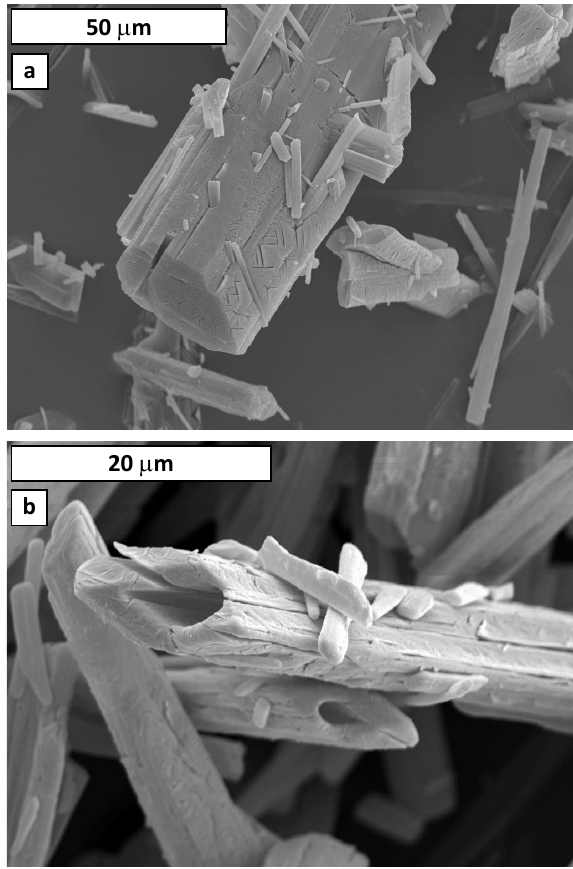
Figure 4: Characteristic prismatic (a) and tubular (b) struvite crystal forms produced in the presence of sulphate(VI) ions. Process parameters: a) 1.0 mass% of PO 43– and 0.10 mass% of SO 42– , pH 9, τ 900 s, PO 43– :Mg 2+ :NH 4+ = 1:1:1, b) 0.20 mass% of PO 43– and 0.50 mass% of SO 42– , pH 9, τ 3600 s, PO 43– :Mg 2+ :NH 4+ = 1:1.2:1.